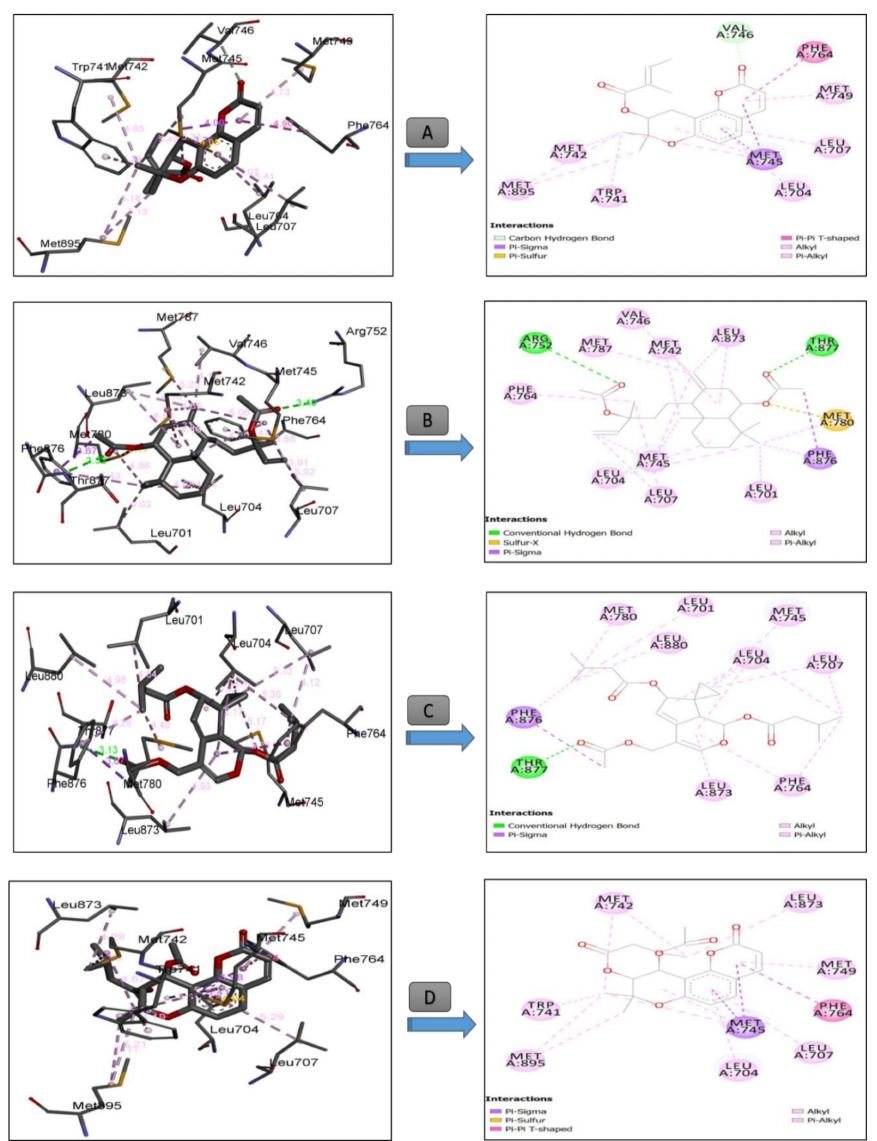
Figure 6. Three-dimensional ( right ) and 2D (left ) closest interactions between the active site residues of the human androgen and some molecules belonging to di ff erent class compounds with the best score result. Legend: ( A ): Compound 15 (Selinidin, Class: coumarin derivative), ( B ): Compound 18 (larixol acetate), ( C ): Compound 19 (Valtratum, Class: Terpene) and ( D ): Compound 22 (dihydrosamidin, Class: